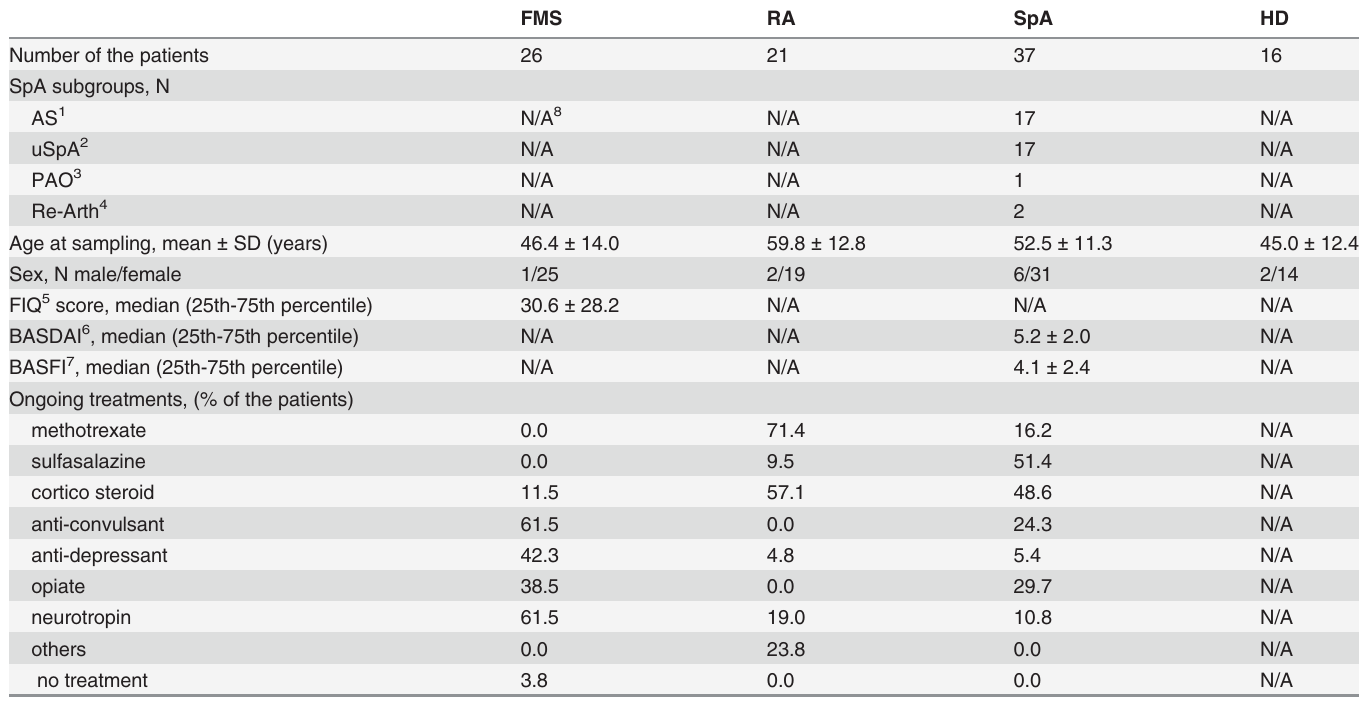
Table 1. Characteristics of the